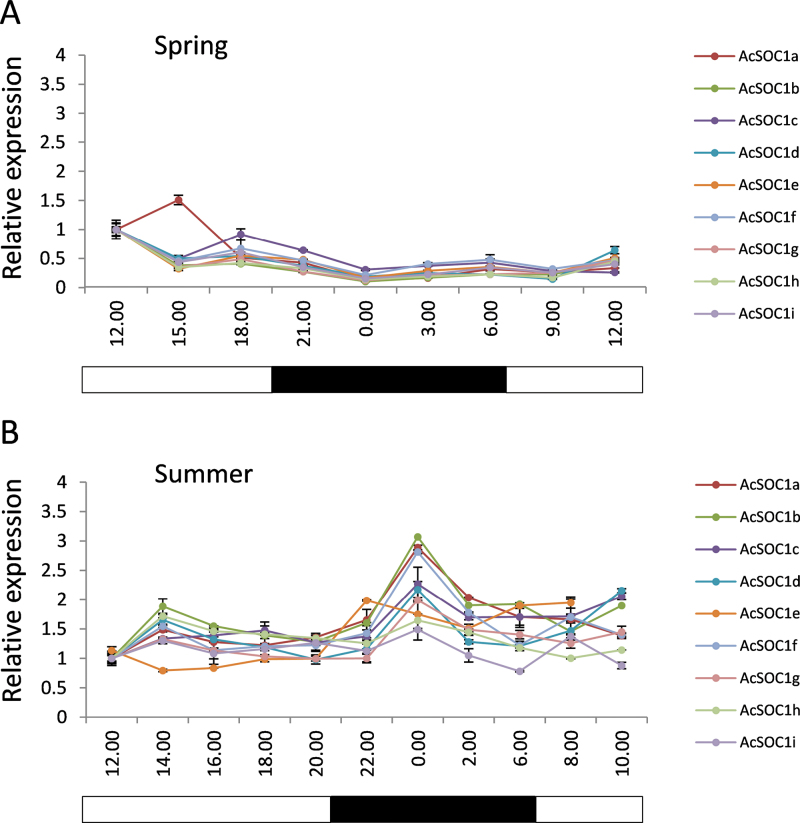
Relative expression of kiwifruit SOC1-like genes in leaf samples collected at regular intervals over a 24h period in spring (A) and summer (B), normalized to kiwifruit ACTIN (ACT) and expressed as a ratio to the first sample point, which was arbitrarily set to 1. Data points represent the mean ±SE for three replicates. The white and black rectangles indicate the daylight and night-time, respectively.